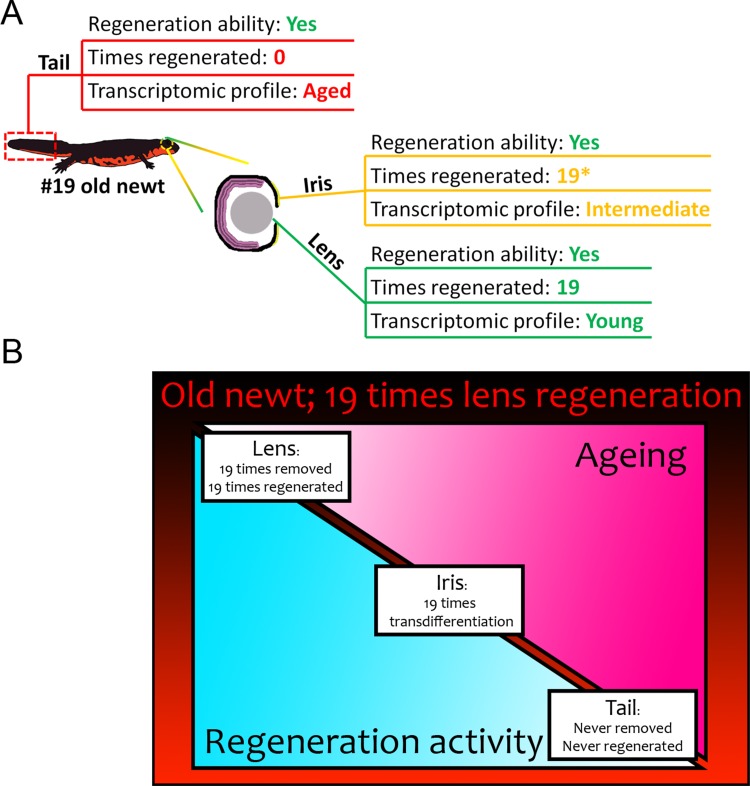
Summary of results from our transcriptomic comparisons between #19 and #0 newts.(A) Tail samples that had never experienced regeneration showed a marked deregulation of electron transport chain, mitochondrion, and ribosome genes, in #19 newts all signatures of ageing. On the contrary, lenses that were regenerated 19 times over a period of 18 years, showed a transcriptomic profile comparable to never-regenerated lenses from young newts. Iris showed an intermediate profile marked by deregulation of electron transport chain-related genes. (B) Regeneration versus ageing in newts. Triangles indicate the amount of regeneration activity (in light blue, decreasing from left to right) and ageing signatures as found by our transcriptomic analysis (in hot pink, increasing from left to right) of sampled #19 tissues. Regeneration initiates a robust transcriptomic program that can be faithfully restarted during repeated insult with no transcriptomic deregulation or molecular signatures of ageing. In our #19 newts, lenses had been fully removed and regenerated 19 times, thus having the highest regeneration activity and showed no signs of ageing. Iris, as the source of lens regeneration, has been regenerated/replenished after transdifferentiation to lens, thus showing some activity and an intermediate profile (the asterisk indicates that iris is not regenerated completely). Tails were never removed or regenerated and showed the most deregulated genes and signatures of ageing compared to the young controls.